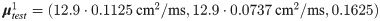
Test 4: Comparison between FOM and DL-ROM solutions for different testing-parameter instances.APs obtained through the FOM and the DL-ROM with n = 4. Left: μtest1=(12.9·0.1125cm2/ms,12.9·0.0737cm2/ms,0.1625) and μtest2=(12.9·0.1125cm2/ms,12.9·0.0737cm2/ms,0.2375); right: μtest1=(12.9·0.0775cm2/ms,12.9·0.0387cm2/ms,0.2125) and μtest2=(12.9·0.1825cm2/ms,12.9·.0912cm2/ms,0.2125). The DL-ROM approximation accurately reproduces the APD variability and the different depolarization patterns.